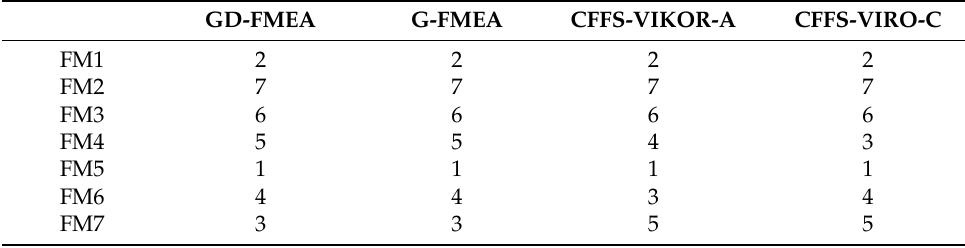
Table 16. Comparison regarding the priorities of FMs.